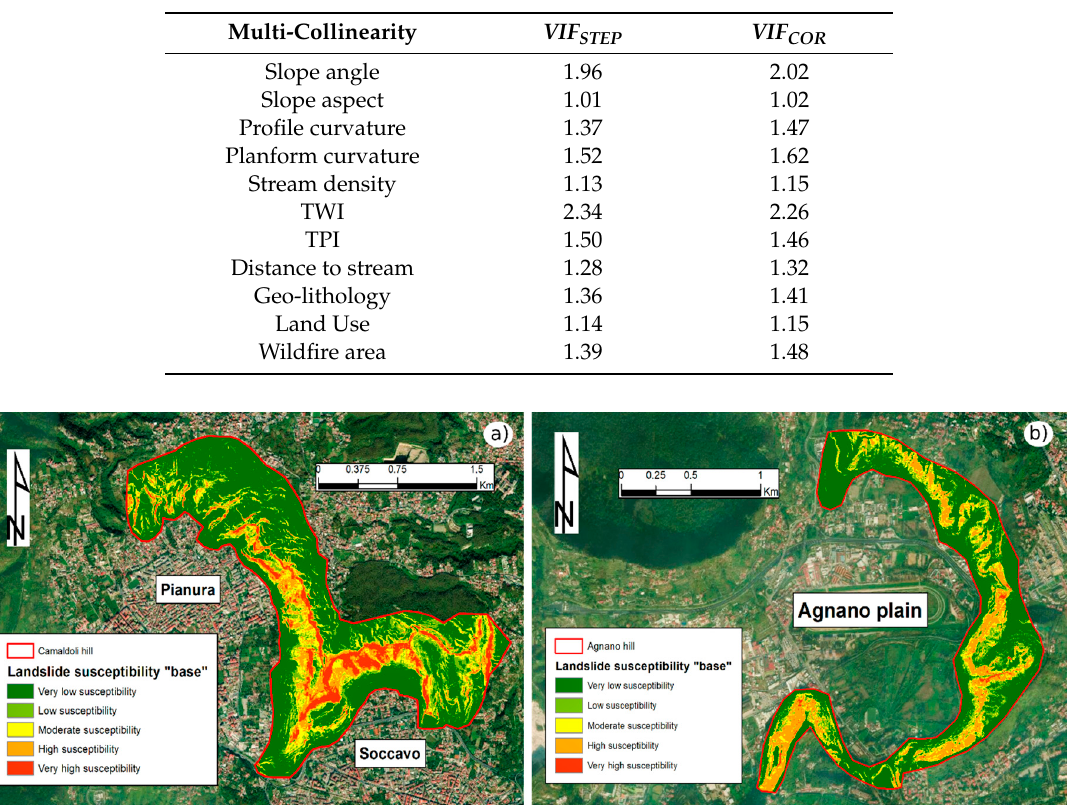
Table 5. Multicollinearity diagnosis indices for variables; such scores represent the mean of the di ff erent models implemented.